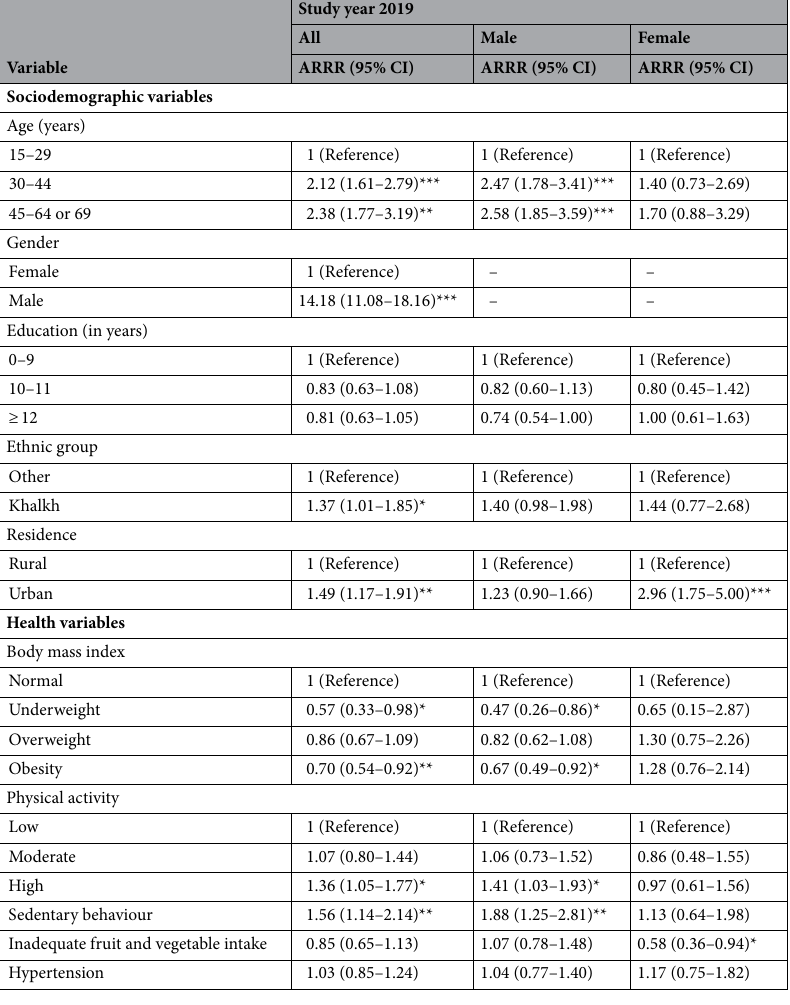
Table 10. Associations with current tobacco use only (with non-current tobacco and non-current heavy drinking as reference category) among 15 years and older individuals in Mongolia, 2019. *** p <